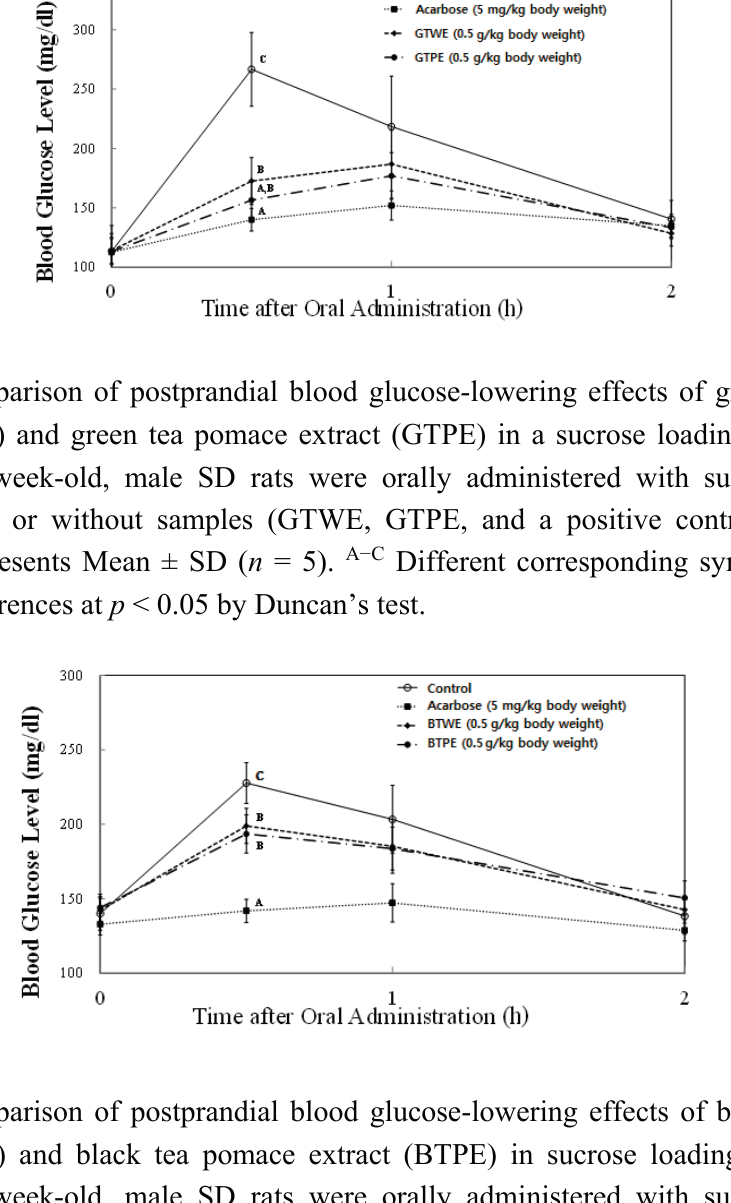
Figure 6. Comparison of postprandial blood glucose-lowering effects of black tea water extract (BTWE) and black tea pomace extract (BTPE) in sucrose loading test. After a 24 h fast, six-week-old, male SD rats were orally administered with sucrose solution (2.0 g/kg) with or without samples (BTWE, BTPE. and a positive control: acarbose). Each point represents Mean ± SD ( n = 5). A-C Different corresponding symbols indicate significant differences at p < 0.05 by Duncan’s